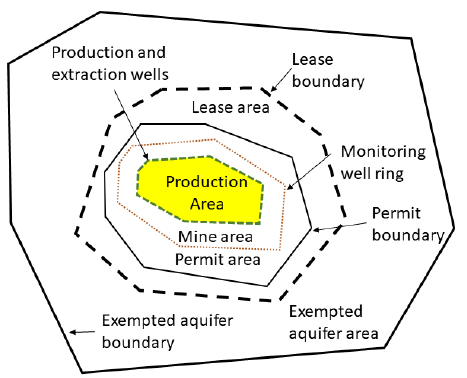
Figure 3. Nomenclature and relationships of the different “area types” associated with a uranium in-situ recovery mine.